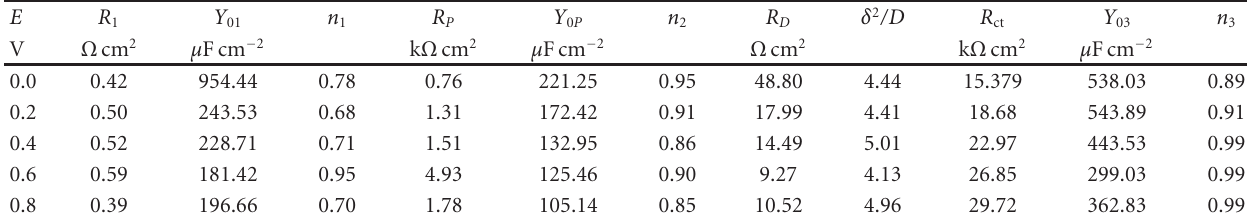
Table 2: Passive element values for the equivalent circuit of Model F obtained from the fitting procedure of